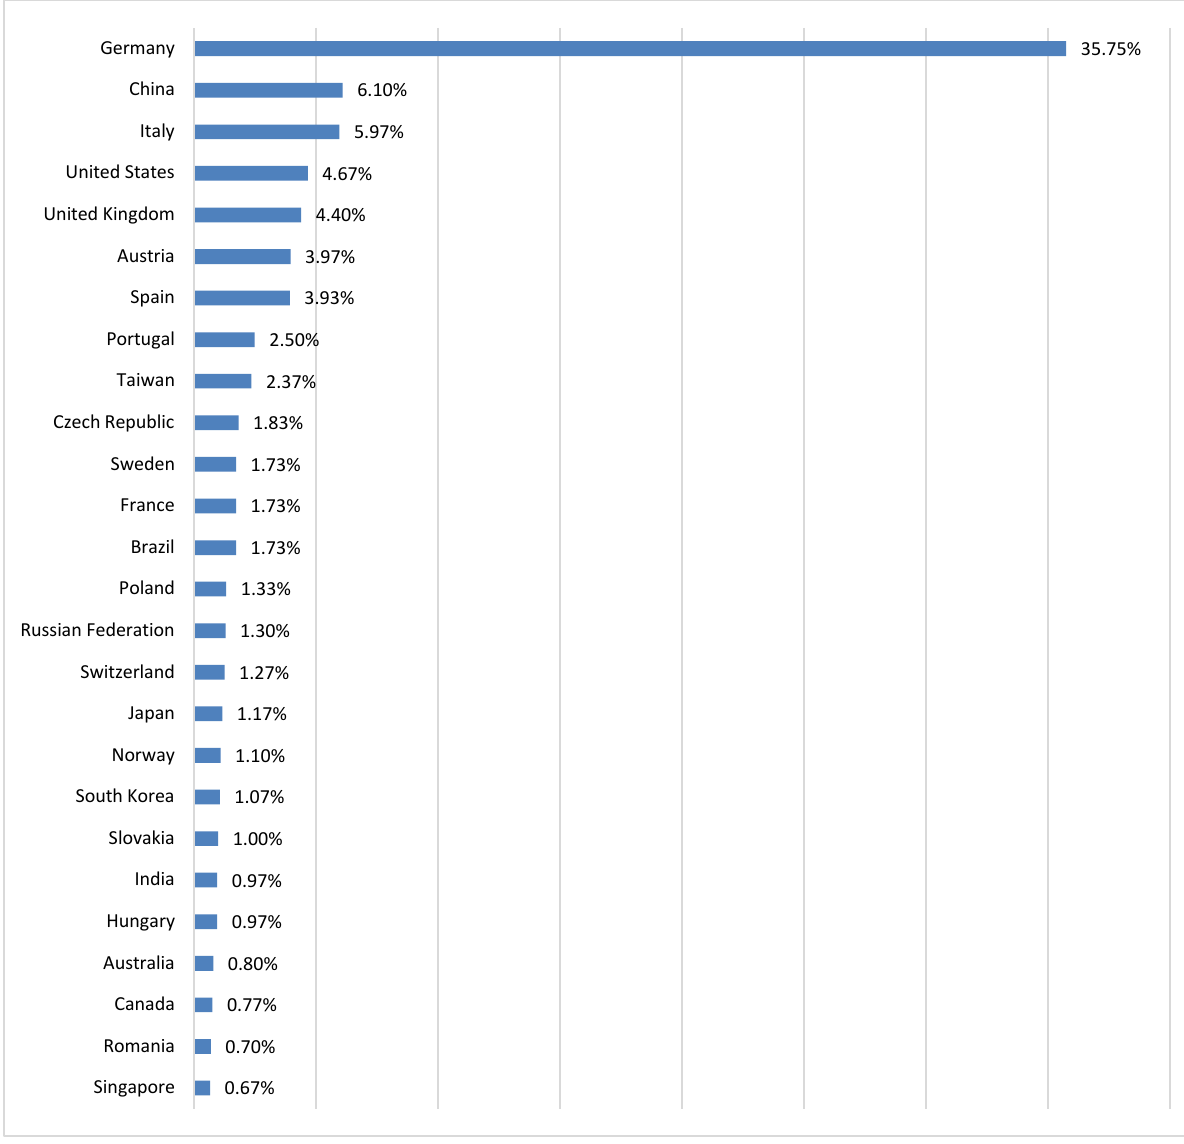
Figure 1. Publications per